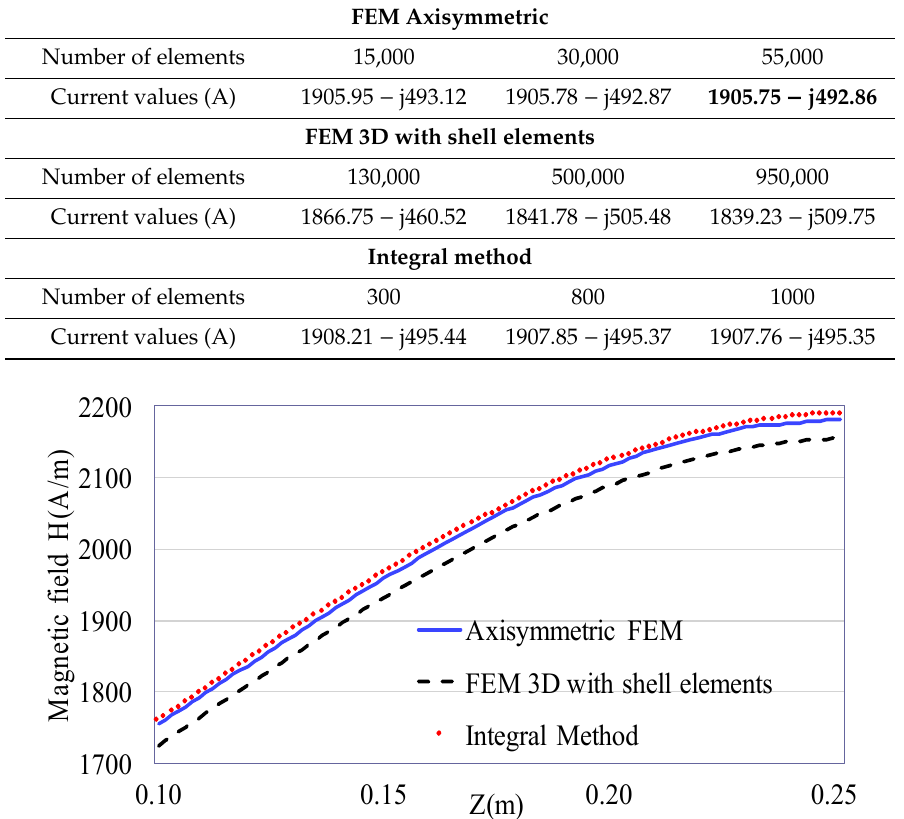
Table 1. Current values in the conductor, where j is an imaginary unit.